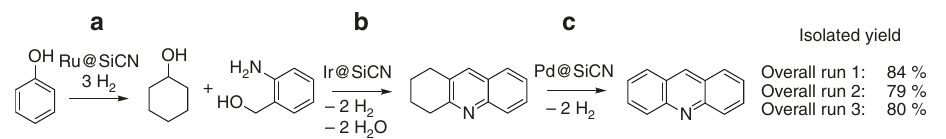
Fig. 3 Direct synthesis of acridine and reusability of the catalysts. a Hydrogenation by Ru@SiCN and catalyst removal. b ADC step applying Ir@SiCN and catalyst removal. c Dehydrogenation using Pd@SiCN and work up of the products. The synthesis was repeated for three times with the same catalysts. The overall yields of the isolated acridine vary between 79 and